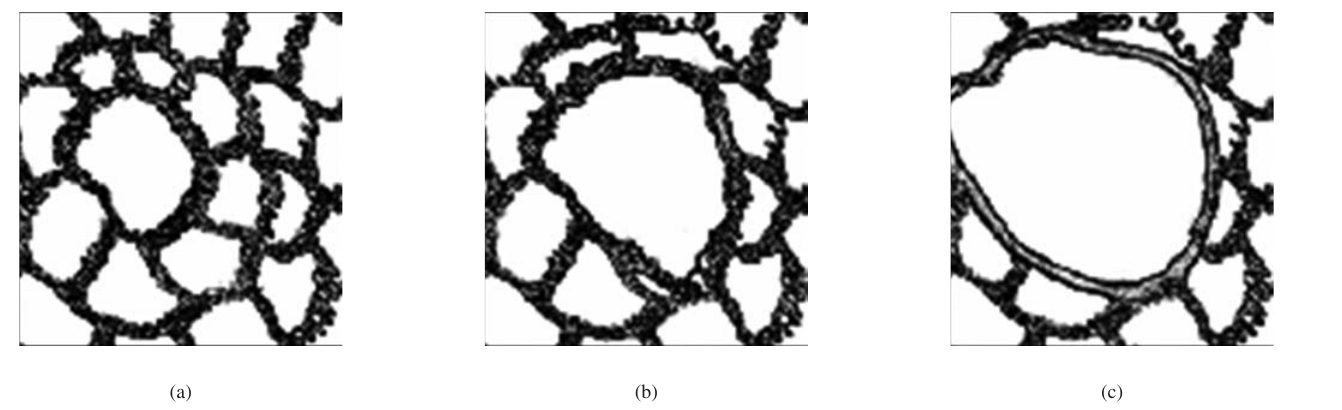
Figure 3. The sequence shows the nucleation of a recrystallized grain starting from a subgrain: a) initial substructure; b) the larger (middle) subgrain growth over the other (smaller) ones; and c) an area free of defects associated to a large angle boundary that is